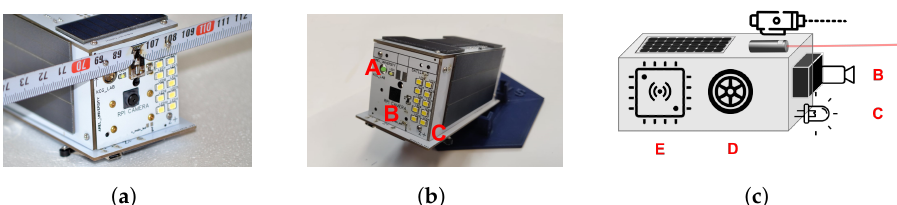
Figure 4. Images and illustration of the SATLLA2.0 nano-satellite engineering model. The left side ( a ) shows the complete engineering model of SATLLA2.0, including a UHF antenna. The image in the middle ( b ) displays the FSO components: (A) laser diode with about 1 degree beam divergence (green 532 nm); (B) Sony’s IMX219 8 MP camera; and (C) an array of 10 LEDs emitting an equivalent to 20 flashes of smartphones. The satellite’s emitting light should be visible from Earth using a small 8 (cid:48)(cid:48) telescope on a clear night. The right side ( c ) illustrates the main components of SATLLA2.0: (A) FSO communication unit and a calibrated laser light; (B) camera with an image processing unit; (C) LED—for ground tracking; (D) stabilization control (reaction wheels) unit; and (E) main controller with UHF radio transmitter-receiver.